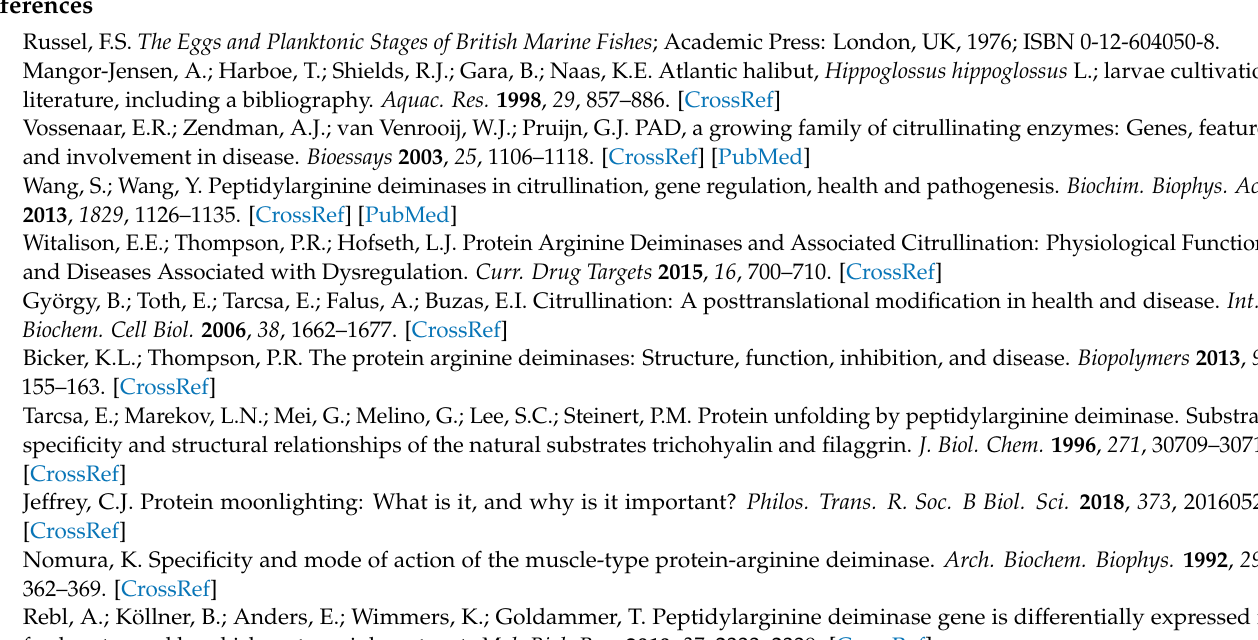
Table S2: Total proteins in serum-EVs of halibut ( Hippoglossus hippoglossus L.); full LC-MS/MS